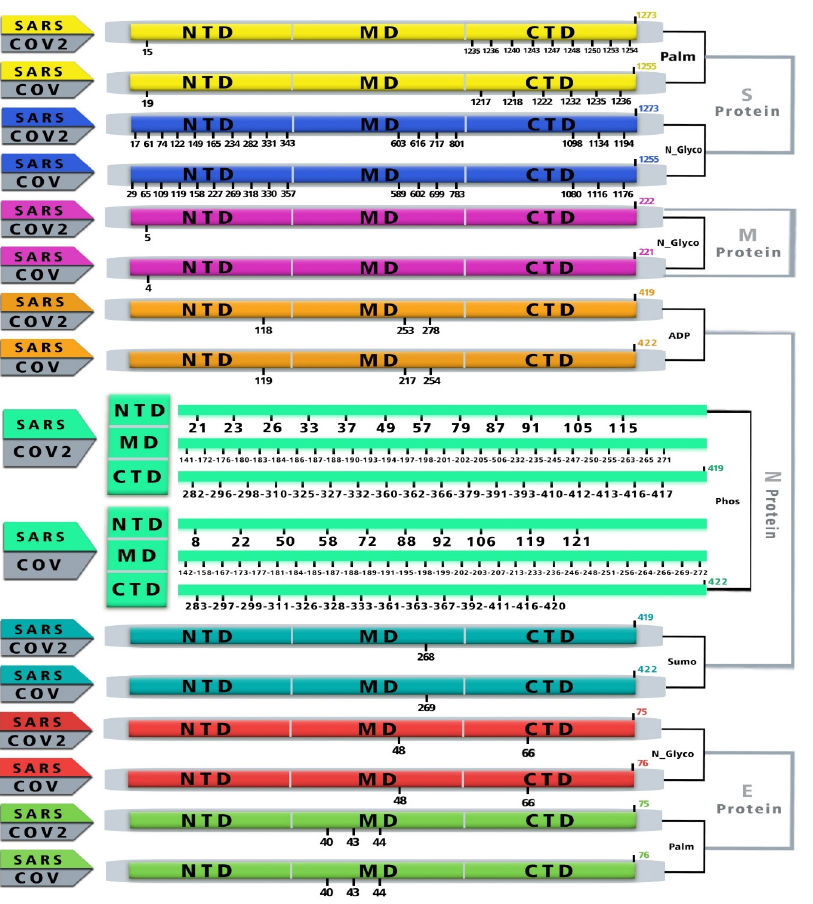
Figure 2. Schematic diagram showing functional domain and PTMs on SARS-CoV and SARS-CoV-2 S, M, N, and E proteins (not to scale). NTD: N-terminal domain, MD: Middle domain, CTD: C-terminals domain, S: Spike, M: Membrane, E: Envelope, N: Nucleocapsid, Palm: Palmitoylation, N- Glyco: N-Glycosylation, ADP: ADP-ribosylation, Phos: Phosphorylation, Sumo: